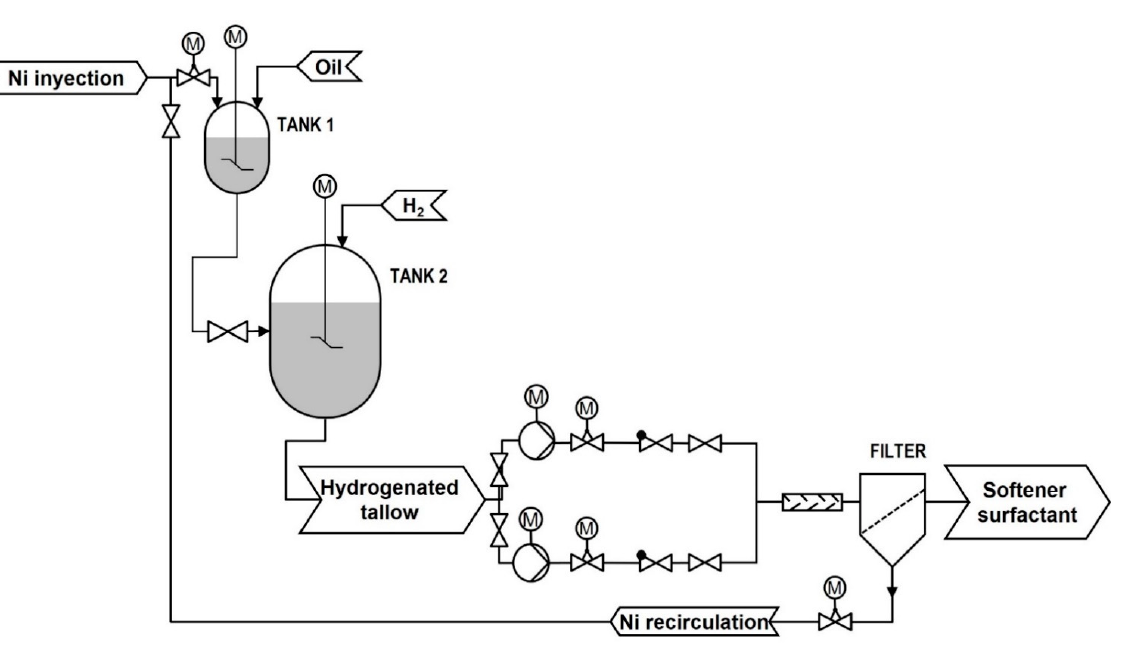
Figure 2. Production process of fabric softeners.